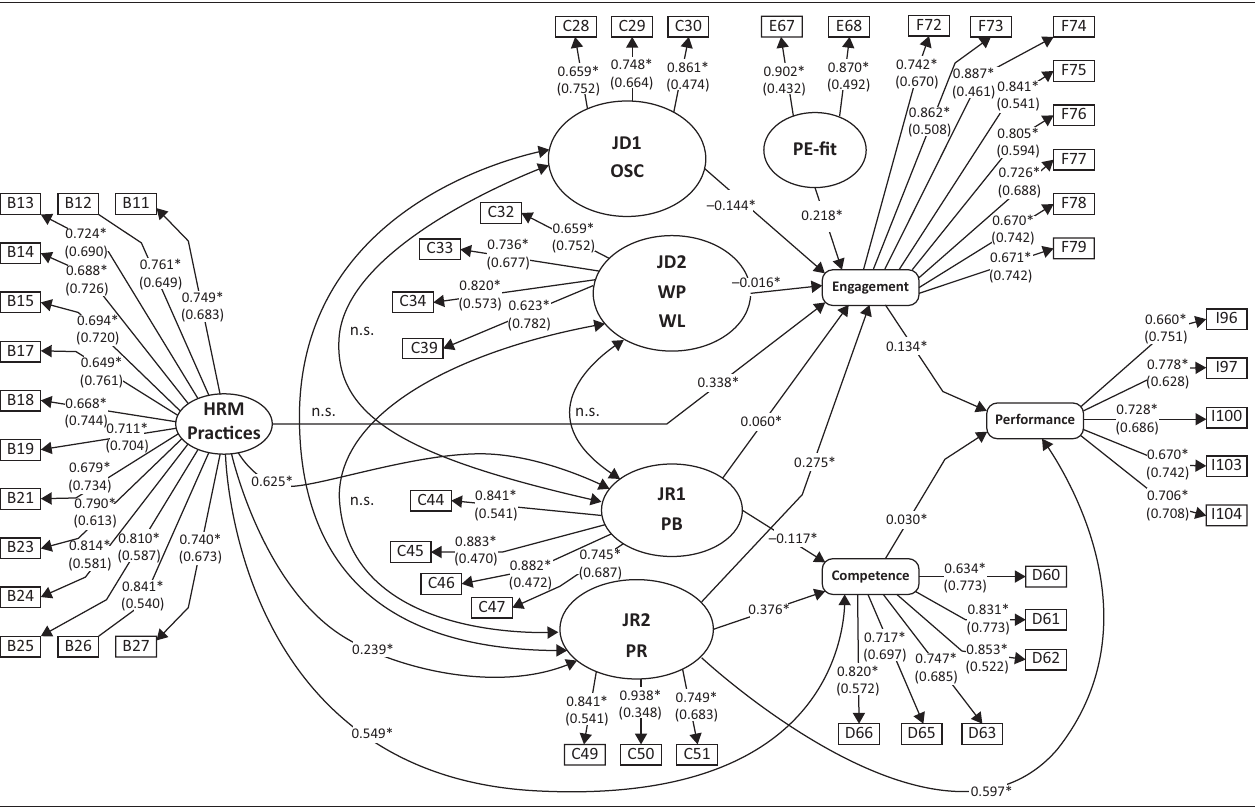
FIGURE 4: Tested and modified Model 2 - Prediction of Individual